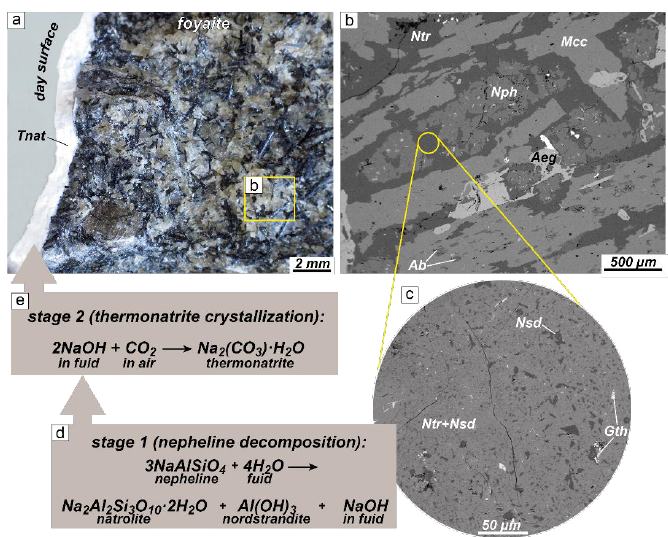
Figure 10. Scheme of the formation of a thermonatrite crust on the surface of a foyaite sample (LV-420, sample point 1 on Figure 1). ( a ) Photo of a sample of foyaite, on the surface of which there is a crust of thermonatrite (diagnosed based on Х -ray data) up to 2 mm thick; ( b ) BSE image of a fragment of a foyaite sample; nepheline is substituted by the association between natrolite + nordstrandite; ( c ) BSE image of a detailed fragment of Figure 10b; ( d ) reaction of replacement of nepheline by the natrolite + nordstrandite association (stage 1); ( e ) thermonаtrite formation reaction (stage 2).